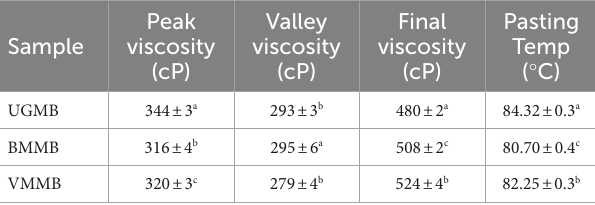
TABLE 3 Pasting characteristics parameters of mung bean flour.